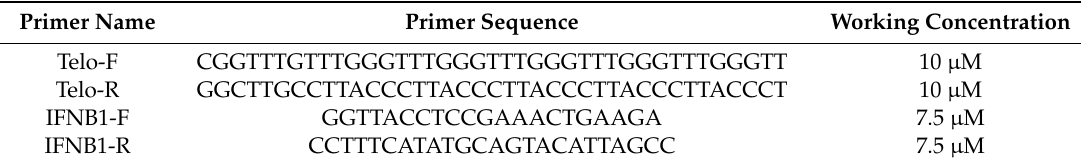
Table A7. Telomere length qPCR primer information.